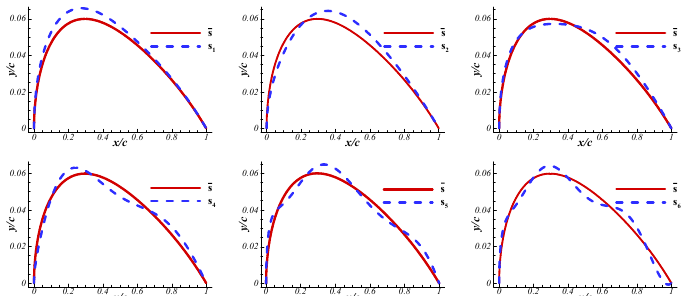
Figure A4. The deformation of the first six POD modes of the airfoil upper surface.